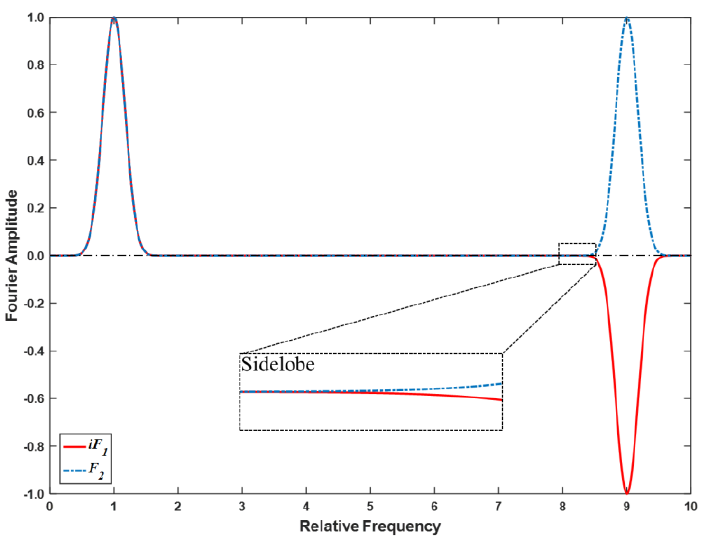
Figure 6. Sampling functions of 10 N − 9 algorithm ( N = 10).